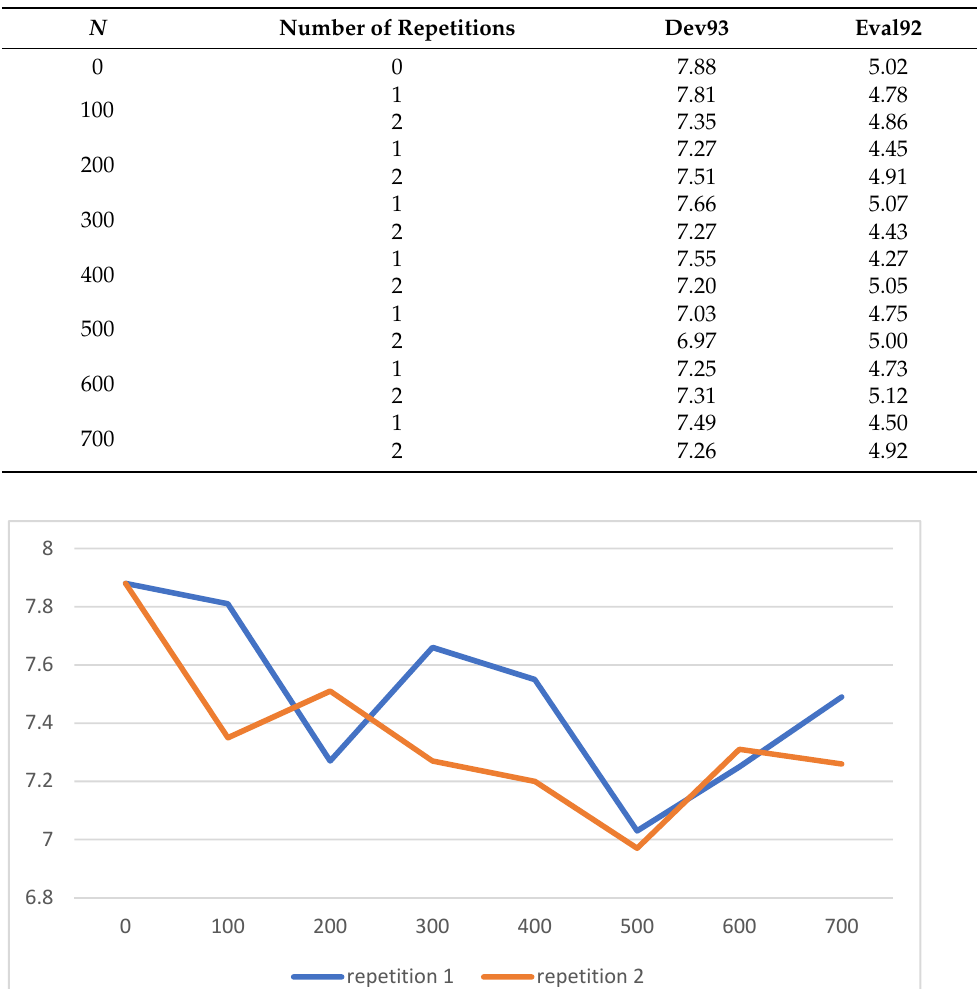
Table 1. WER (%) results of WSJ database according to the maximum augmentation range N when s ∼ Uniform [ 0.9,1.1 ] .